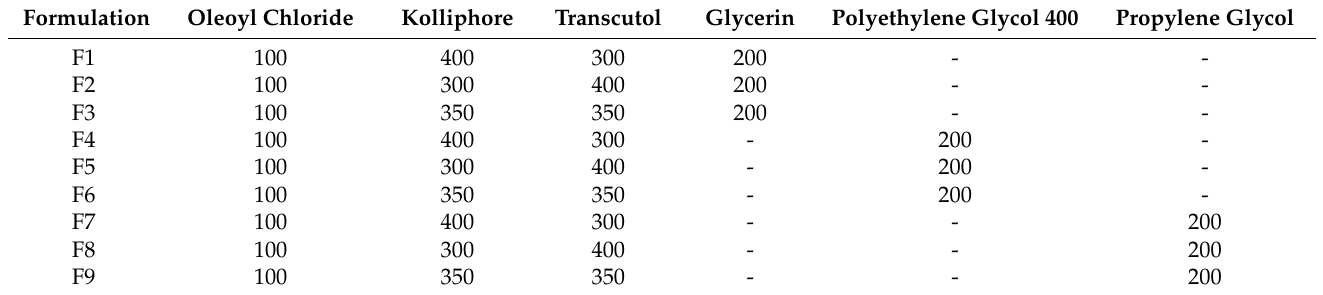
Table 1. Composition of numerous SEDDS formulations. The quantities are expressed in milligrams (mg).